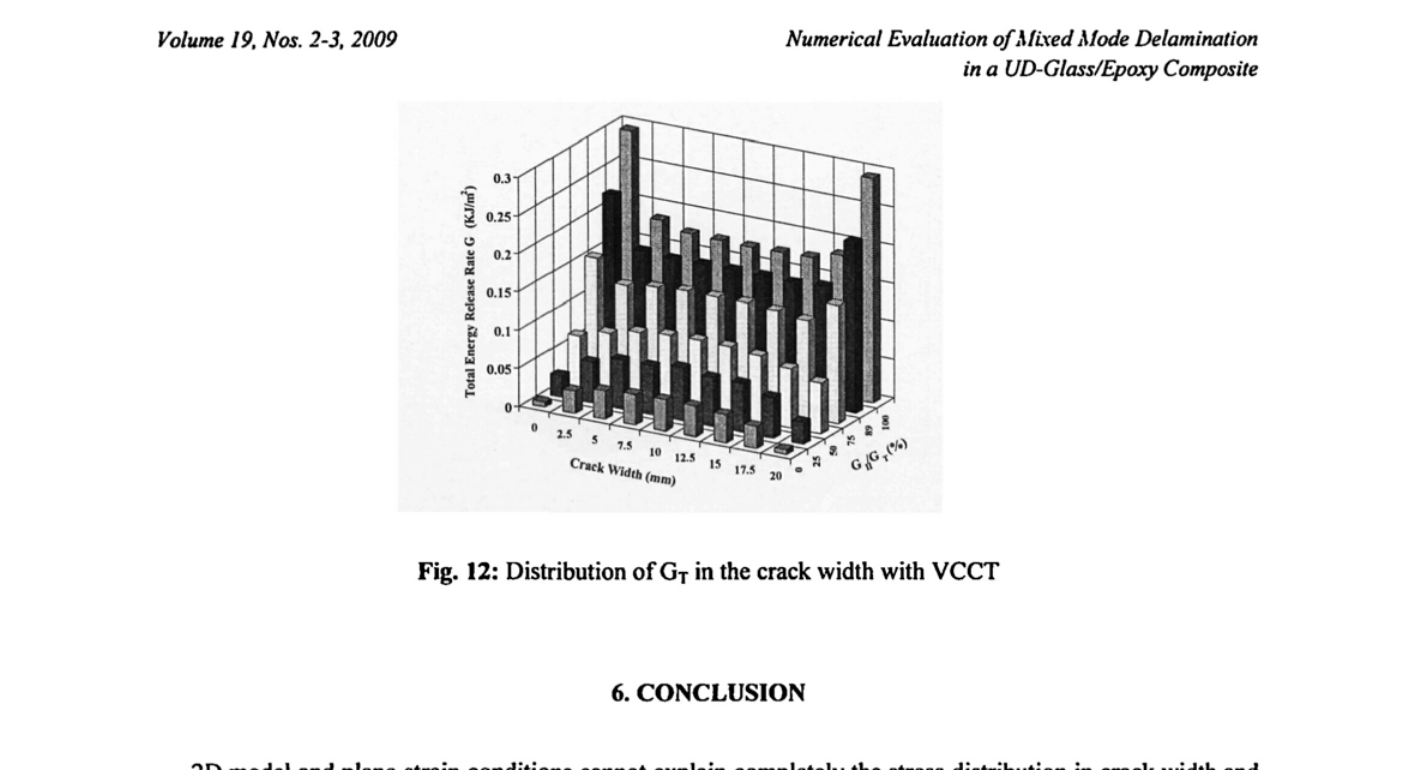
Fig. 12: Distribution of G